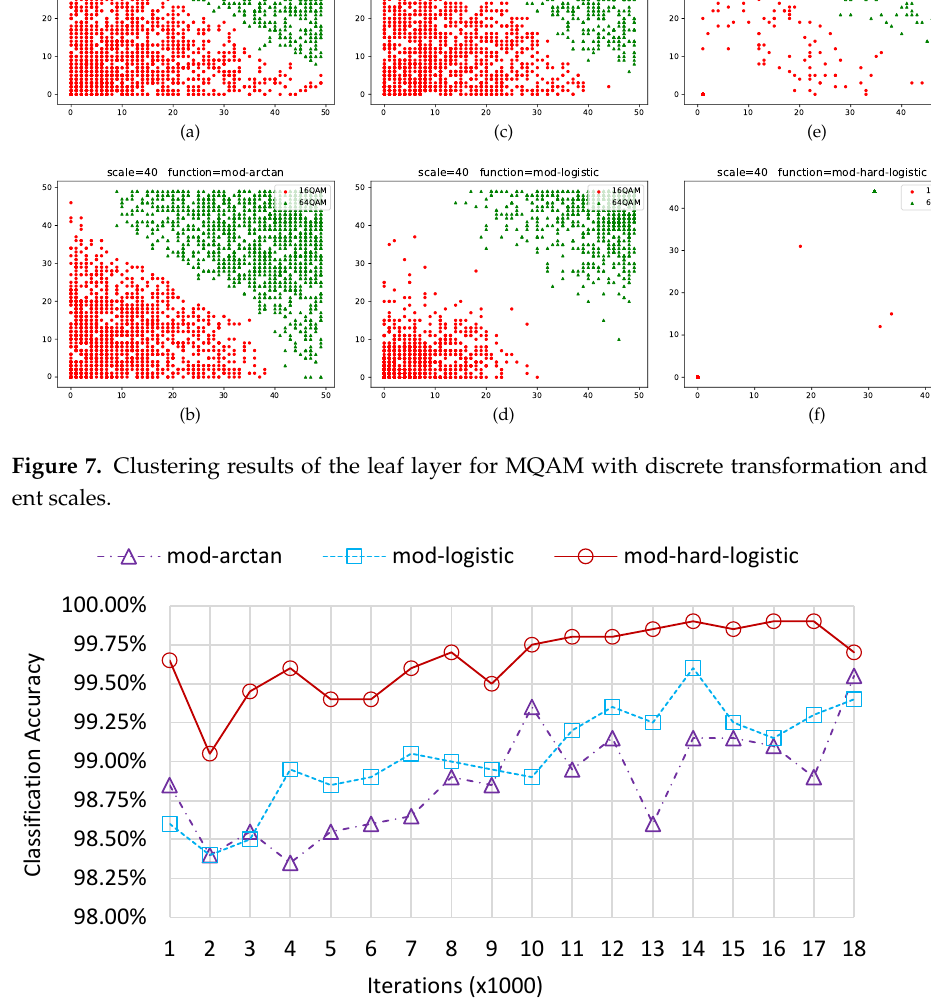
Figure 8. Classification accuracy of the leaf layer for MQAM with discrete